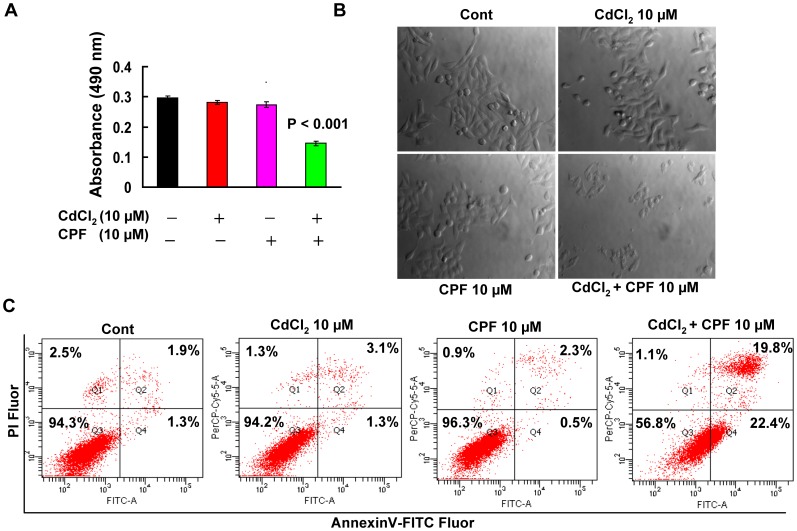
The concomitant exposure of Cd2+ and CPF resulted in toxicity to Hep G2 cells.(a) The MTT assay of cells treated individually or jointly with Cd2+ and CPF at 10 µM for 24 h (n = 6). (b) The phase-contrast images showed the alternations to the cellular morphology upon Cd2+ and CPF treatment. The original magnification was 200×. (c) The representative images of FACS analysis of cell death upon single or joint exposure to Cd2+ and CPF for 24 h using the FITC-conjugated Annexin V and PI staining. There were three biological replicates for each group (n = 3).